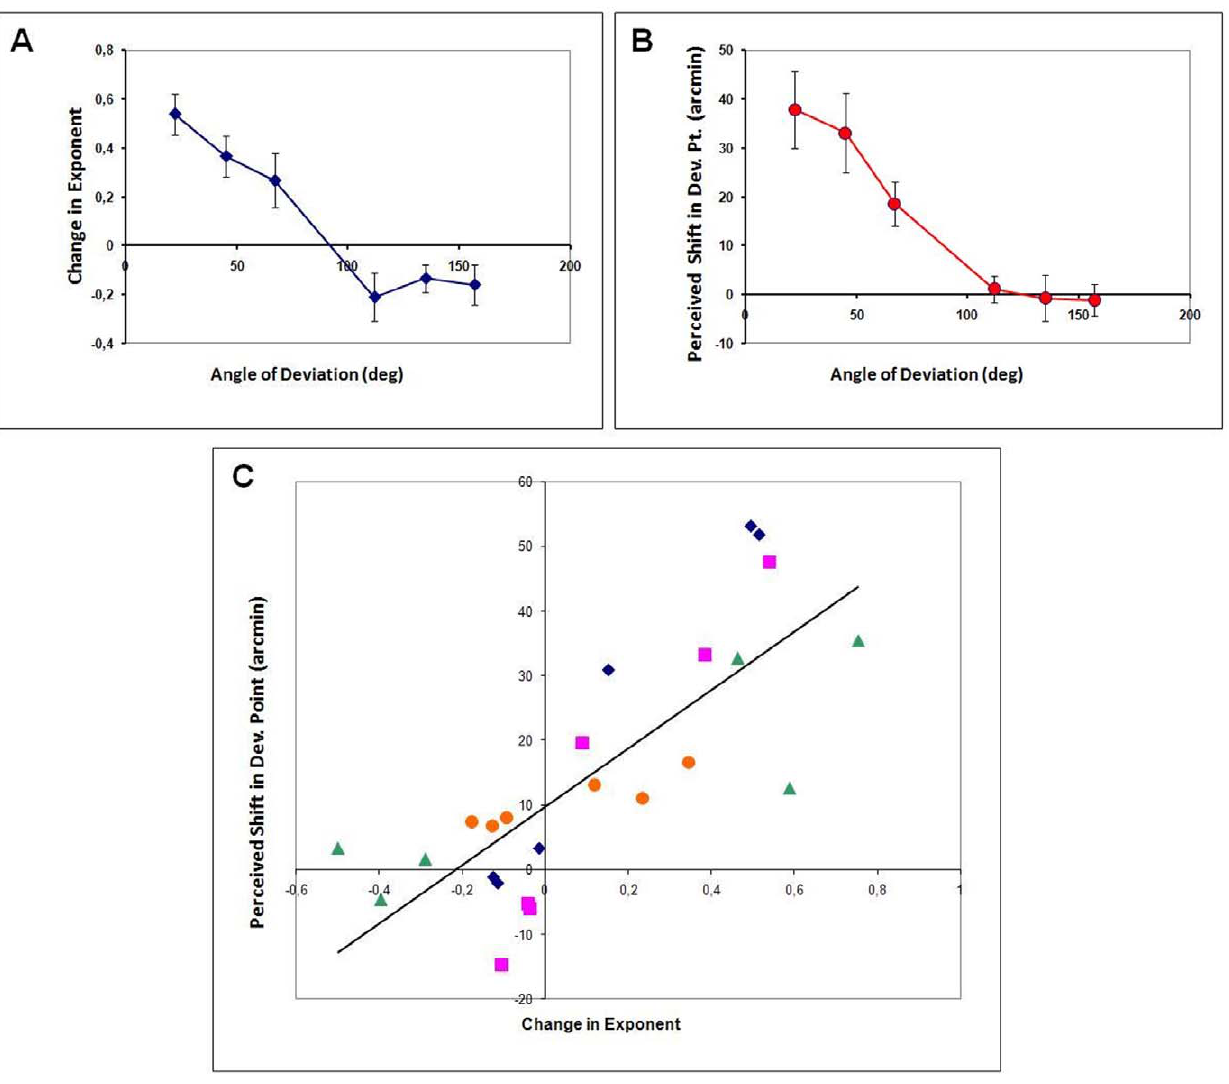
Figure 6. The results of Experiment 2. A. The change in the exponent parameter, averaged over the four observers, for the six deviation angles tested. Error bars represent 6 1 SEM. Positive exponents for the deviations of 22, 45 and 67 deg indicate smoothing of trajectories whereas the negative exponents for deviations of 112, 135 and 157 deg indicate sharpening. B. The shift in the perceived point of deviation (in arcmin), averaged over the four observers, for the six deviation angles tested. Positive values for deviations of 22, 45 and 67 deg indicate a shift of the deviation point in the direction of initial horizontal motion. C. The shift in deviation point (in arcmin) is plotted against the change in exponent value for the four observers (indicated by symbols with different shapes). The straight-line fit to the data is also shown (thick diagonal